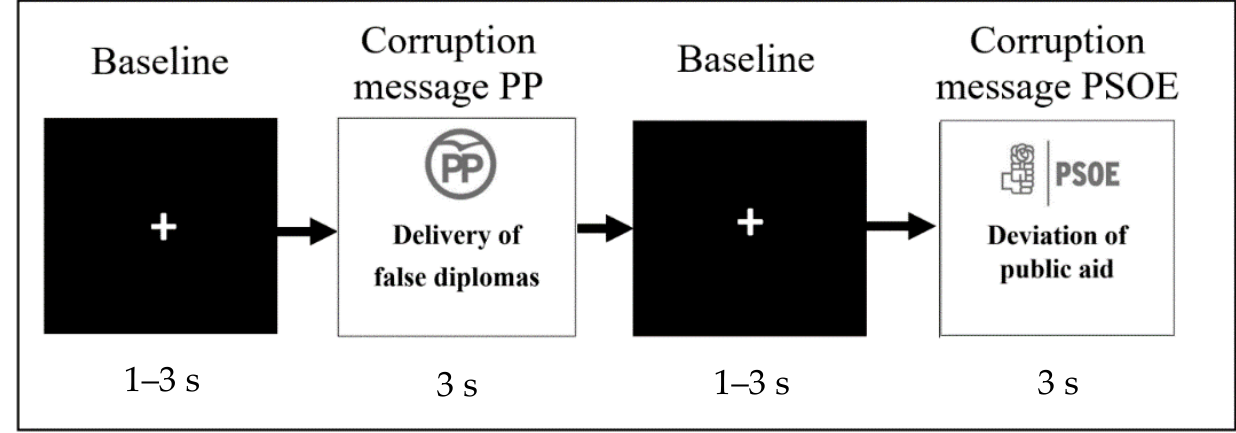
Figure 1. Depiction of the experimental design of the functional Magnetic Resonance Imaging (fMRI) task.